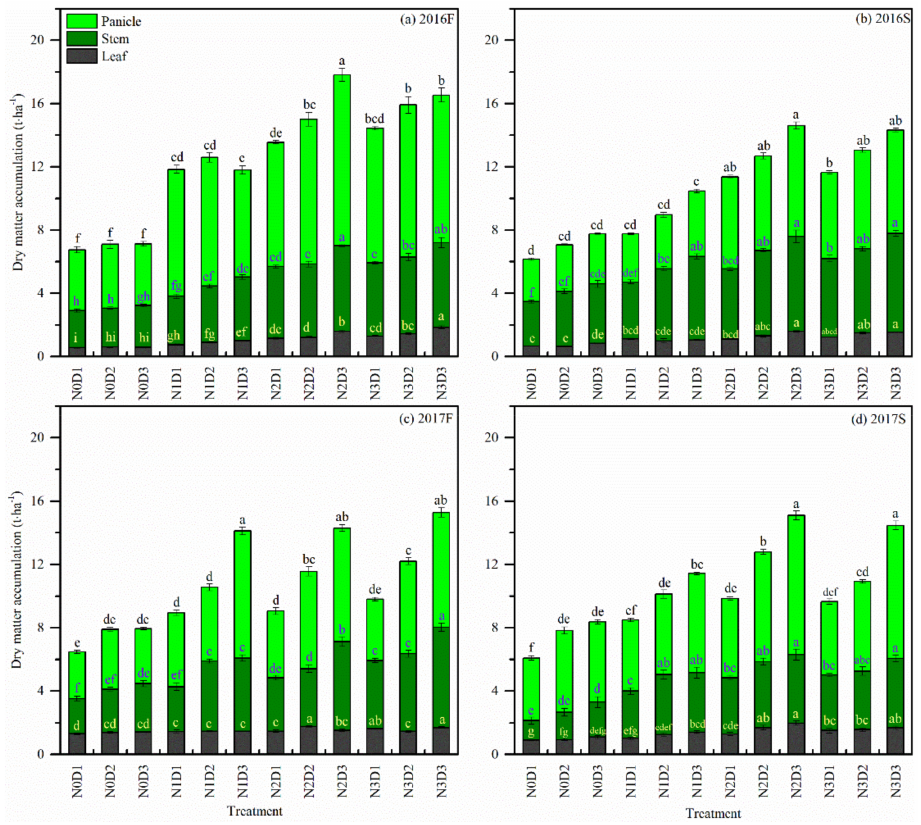
Figure 3. Dry matter accumulation of different treatments. ( a ) Dry matter accumulation in 2016F. ( b ) Dry matter accumulation in 2016S. ( c ) Dry matter accumulation in 2017F. ( d ) Dry matter accumu- lation in 2017S. Dry matter accumulation, including the dry matter of stem, leaf, and grain. 2016F, the first season of 2016 (transplanting season). 2016S, the second season of 2016 (regrowth season). 2017F, the first season of 2017 (regrowth season). 2017S, the second season of 2017 (regrowth season). Bars with different letters represent a significant difference at p < 0.05. The yellow letter represents the difference in the leaf. The purple letter represents the difference in the stem. The dark letter represents the branch and a difference in the